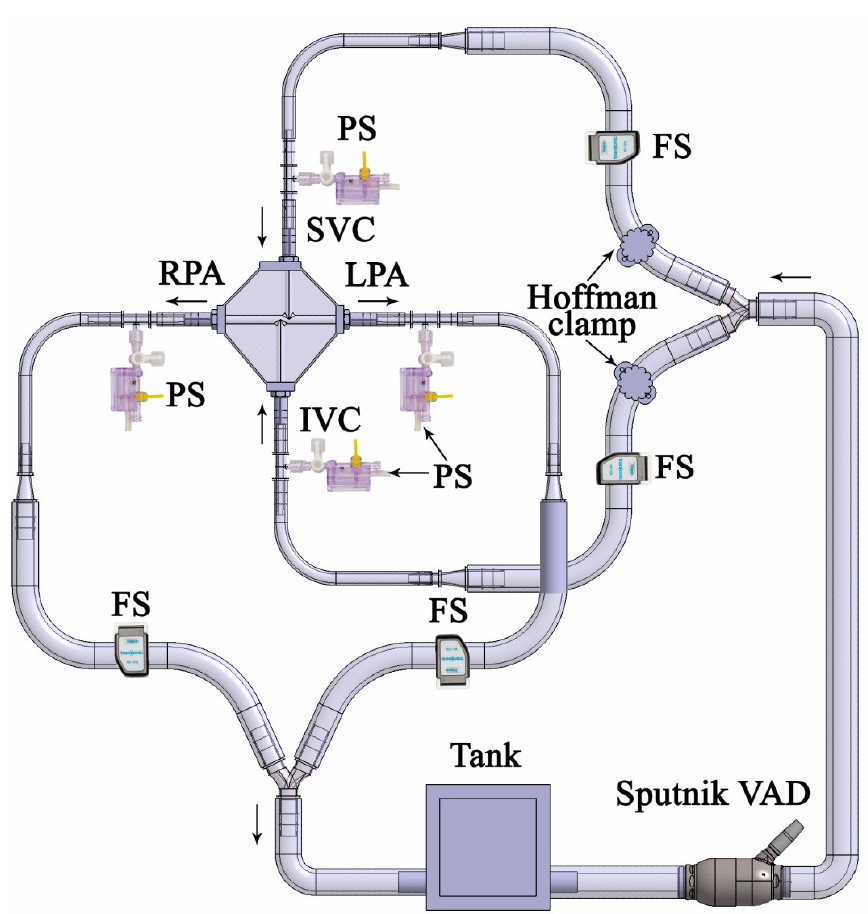
Figure 3. Mock circulation loop, where constant flow generated by Sputnik pump. Changes in pressure and flow in LPA, RPA, IVC, and SVC were detected by FSs (flow sensor) and PSs (pressure sensor). The flow direction is shown by arrows.